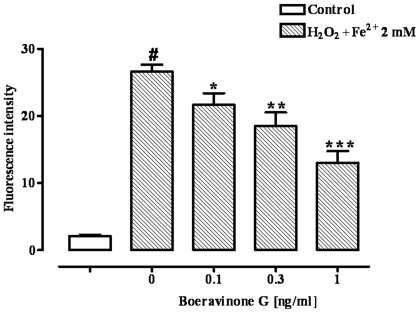
Effect of boeravinone G (0.1–1 ng/ml) on Fenton's reagent (H2O2/Fe2+ 2 mM)-induced reactive species (ROS) production.Effect observed in differentiated Caco-2 cells after 24-hour boeravinone G exposure. Data represent mean ± SEM of 6 experiments. #p<0.001 vs control (vehicle); *p<0.05, **p<0.01 and ***p<0.001 vs H2O2/Fe2+ alone.